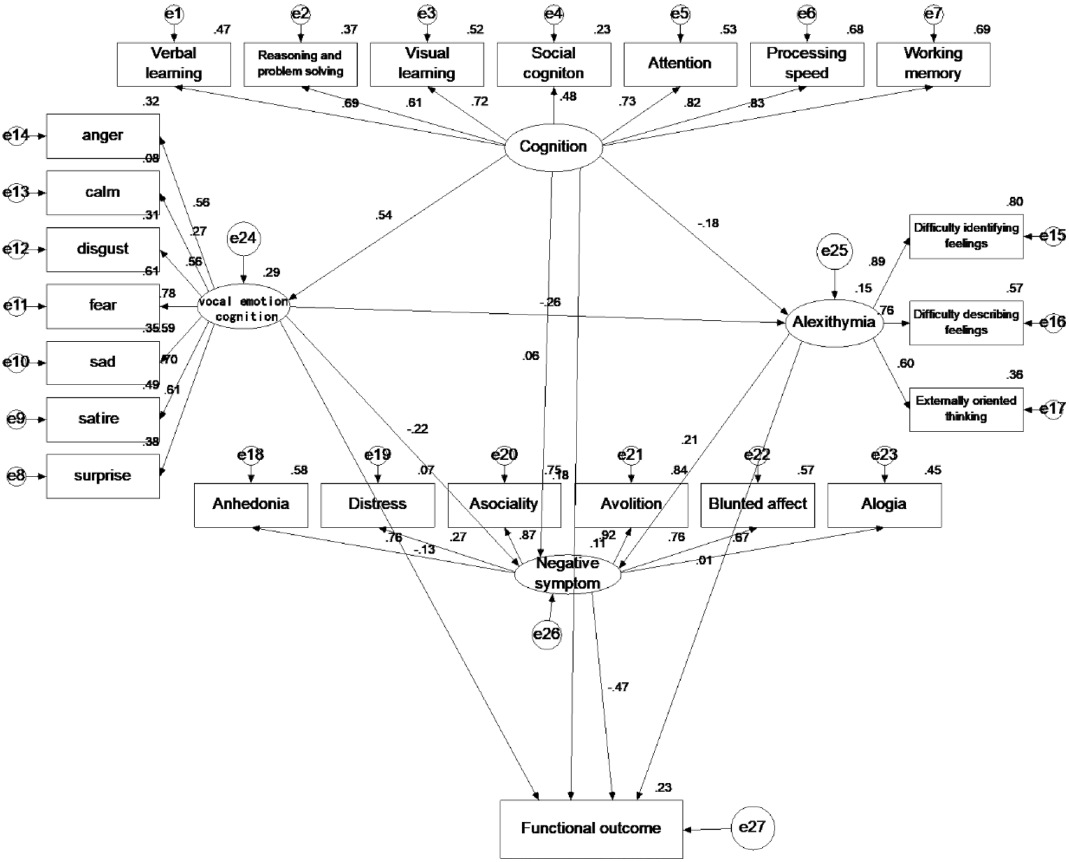
Figure 2. Model 1: Initial Model. This figure is a schematic of the initial, non-trimmed, structural model that includes all of the variables